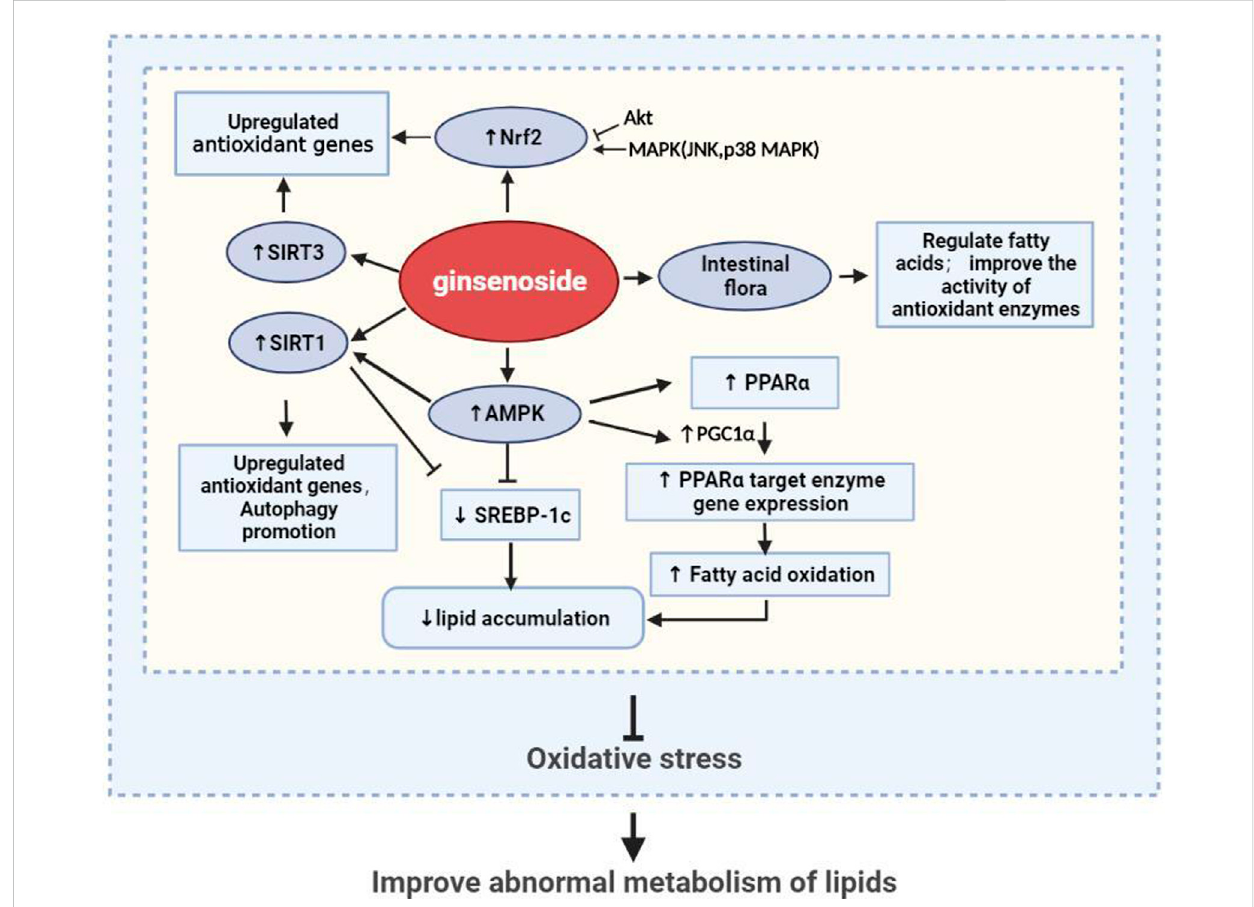
FIGURE 5 Ginseng and its active ingredients reduce lipid accumulation and promote antioxidation through multiple